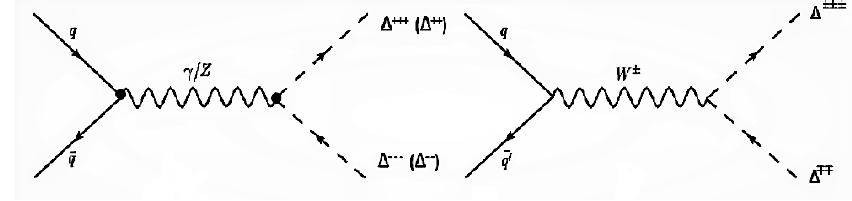
=m tree in the ( M (cid:1) (cid:0) M (cid:6) ) plane. (cid:23) (cid:23)